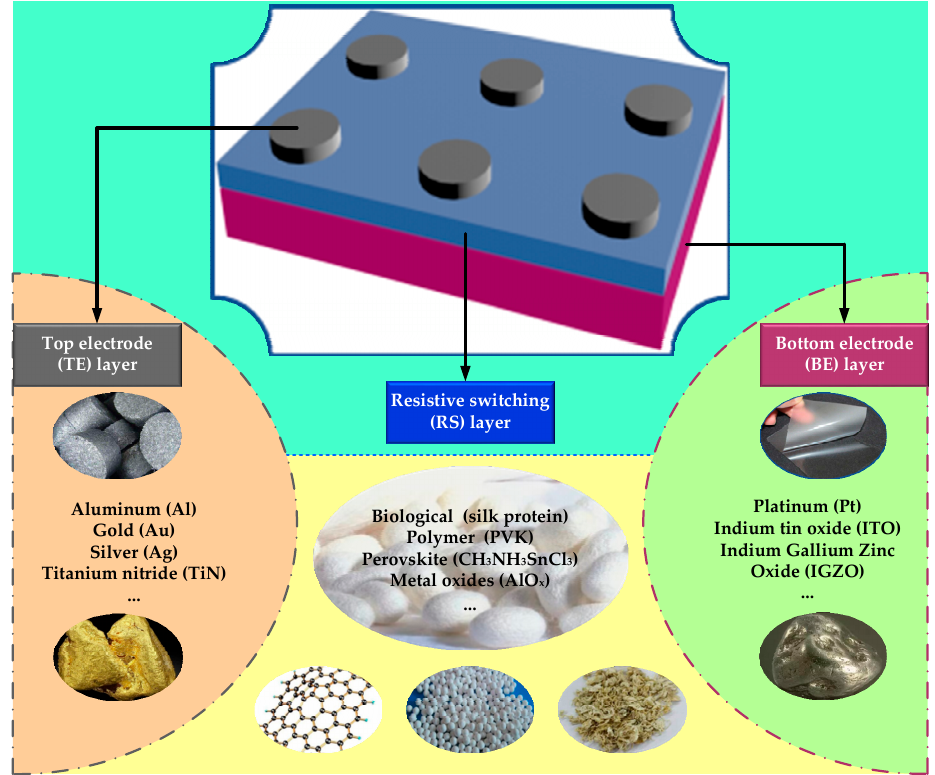
Figure 1. Illustration of sandwich structure for RRAM devices.